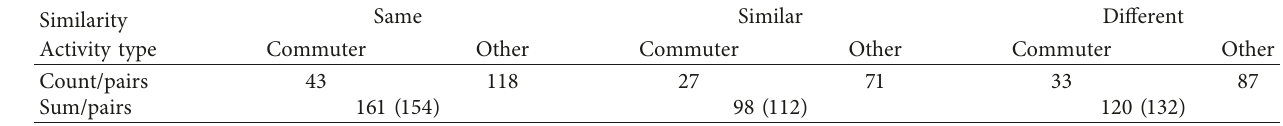
Table 6: Trip paths similarity of residents in